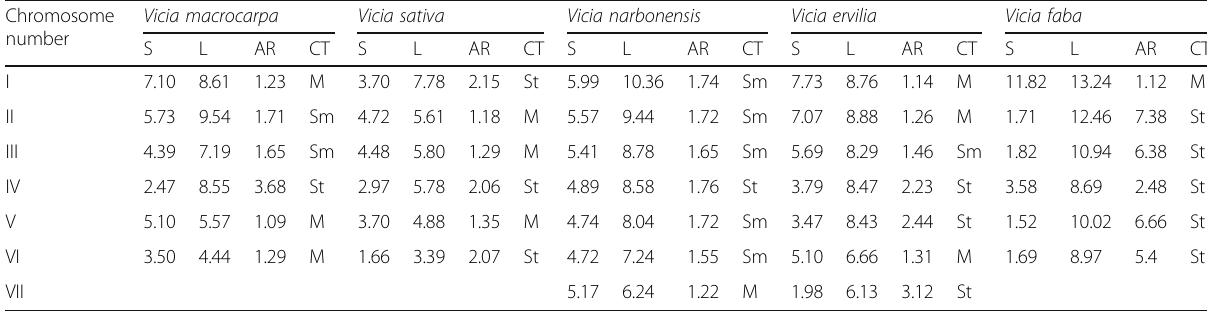
Table 1 The principal characteristics of the chromosomes of the haploid complement of five Vicia species Chromosome